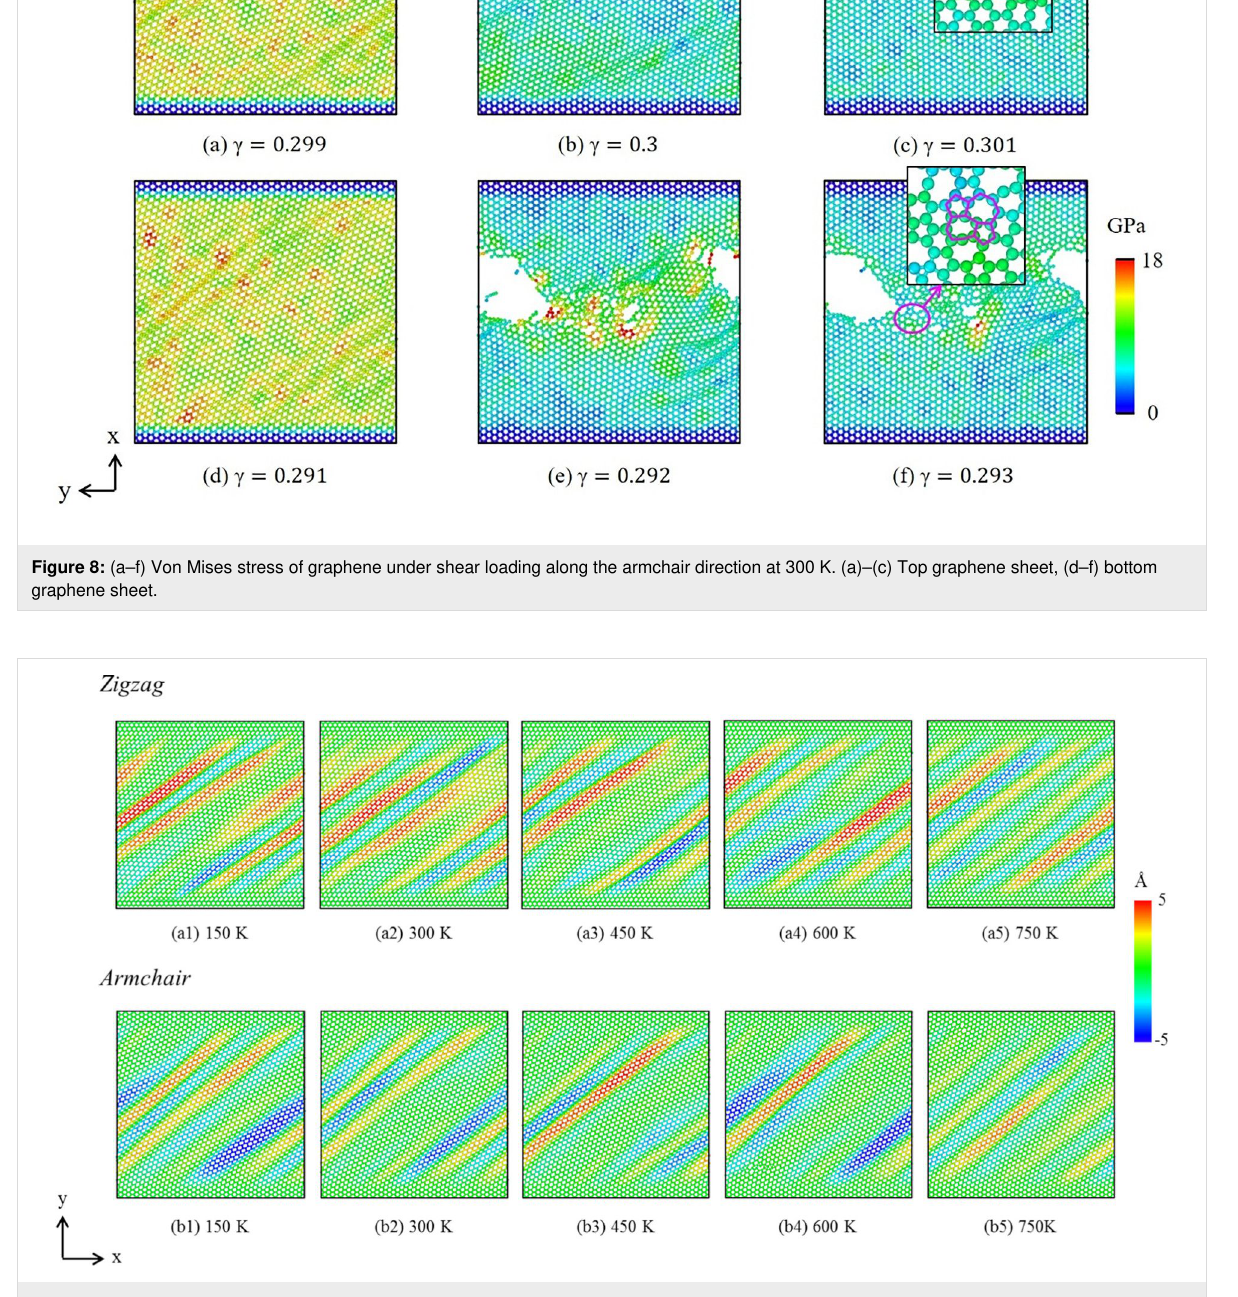
number of the stairs increases with an increase of the layer numbers. Therefore, it can be concluded that graphene and copper do not fracture simultaneously but layer by layer, which